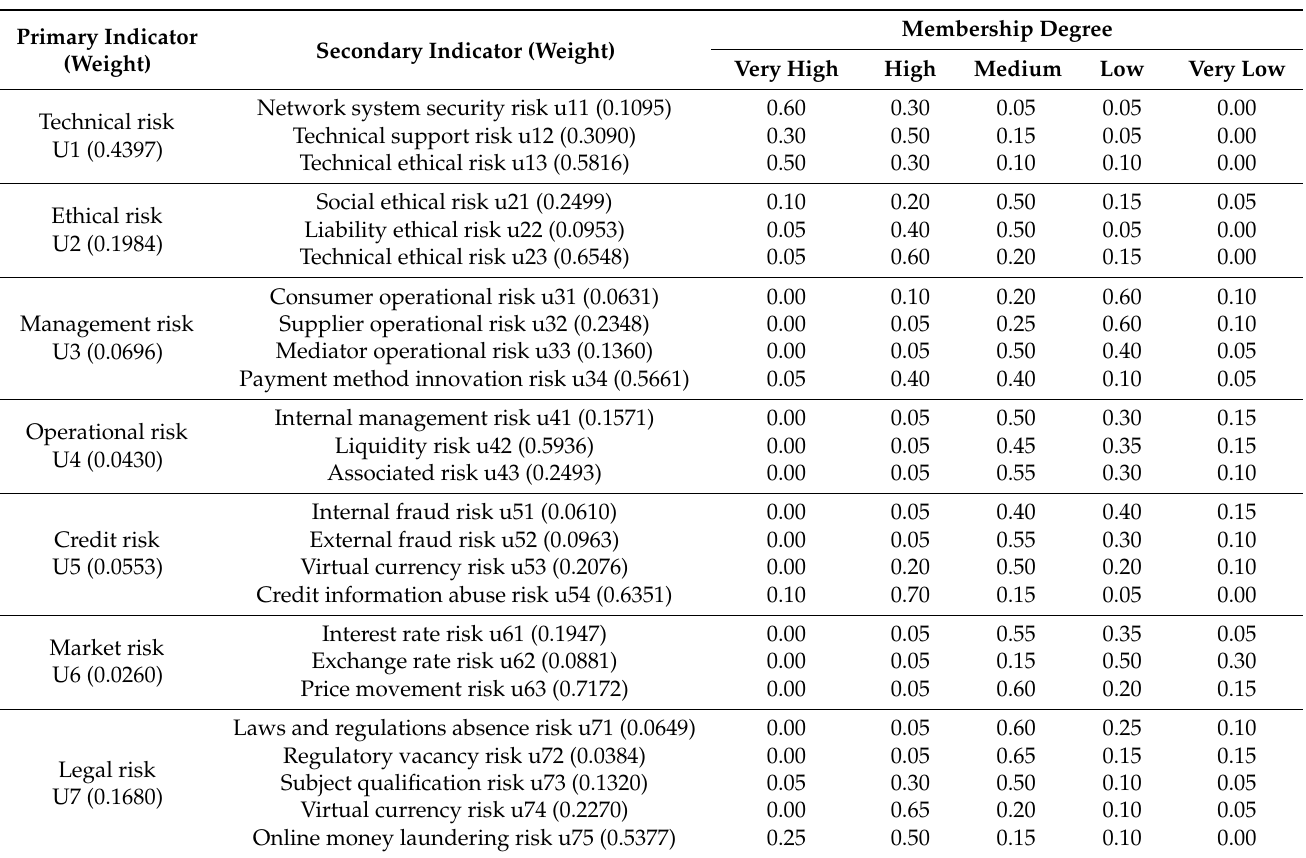
Table 5. Single factor fuzzy evaluation of Fintech